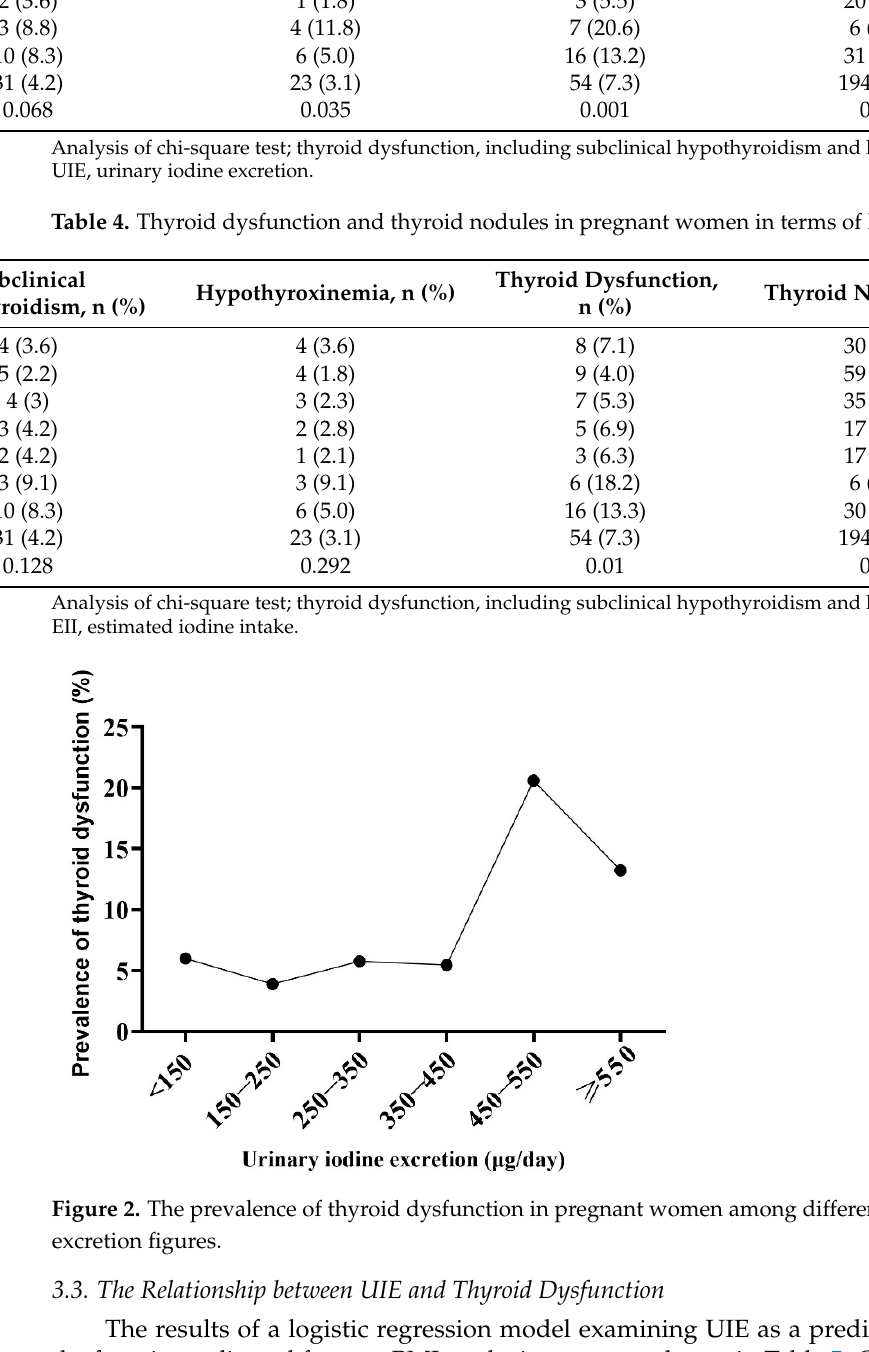
Table 3. Thyroid dysfunction and thyroid nodules in pregnant women in terms of UIE (N = 744).